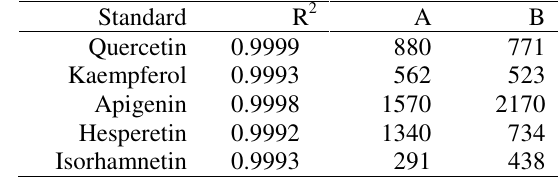
Table 2. Standard regression analysis data.